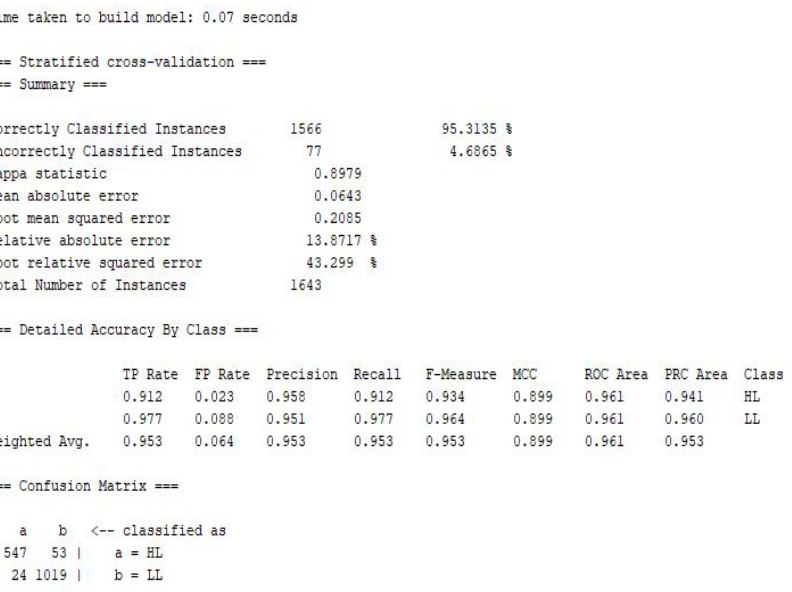
Figure 2: J48 decision tree model for training